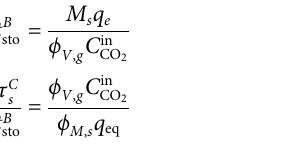
FIGURE 2 | Schematic of the experimental set-up. Blue arrows illustrate gas fl ow direction and red arrows illustrate solid fl ow direction (in case of a continuous